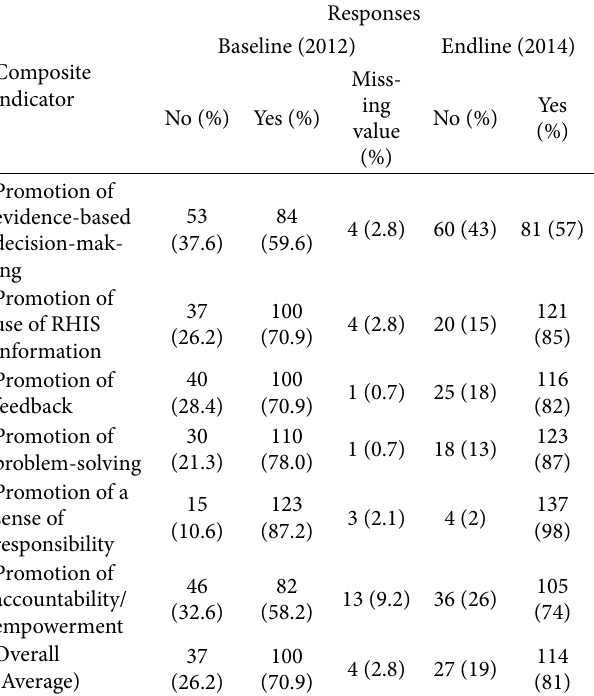
Source: 2012 and 2014